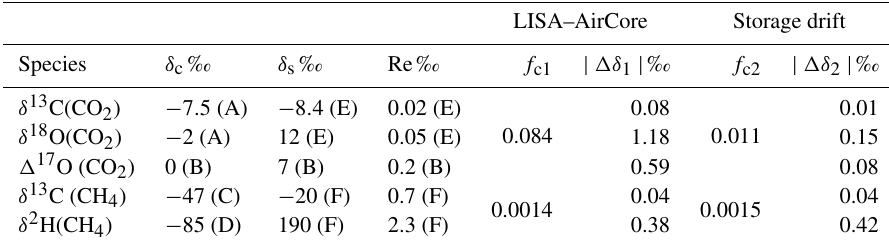
Table 7. Expected bias in stable isotope measurements on samples obtained by LISA, due to the limited accuracy of the LISA sampler. Typical values for the troposphere and stratosphere are taken from the indicated references: (A) Trolier et al. (1996); (B) Mrozek et al. (2016); (C) Nisbet et al. (2016); (D) Bergamaschi et al. (2001); (E) Aoki et al. (2003) and (F) Röckmann et al. (2011). Reported measurement reproducibility, Re, for stratospheric air is also provided. δ 13 C and δ 18 O values are with respect to Vienna Pee Dee Belemnite (VPDB) and (cid:49) 17 O and δ 2 H are with respect to Vienna Standard Mean Ocean Water (VSMOW). f c was calculated using a source value 395ppm (CO 2 ) and 500ppb (CH 4 ), and contamination mole fraction of 405ppm (CO 2 ) and 1800ppb (CH 4 ). For f c1 contamination values of 0.84ppm (CO 2 ) and 1.8ppb (CH 4 ) based on LISA AirCore observed mean bias, resulting in (cid:49)δ 1 . For f c2 the maximum observed drift (Fig. 2) of 0.11ppm (CO 2 ) and 2 (CH 4 ) are used, resulting in (cid:49)δ 2 . LISA–AirCore Storage